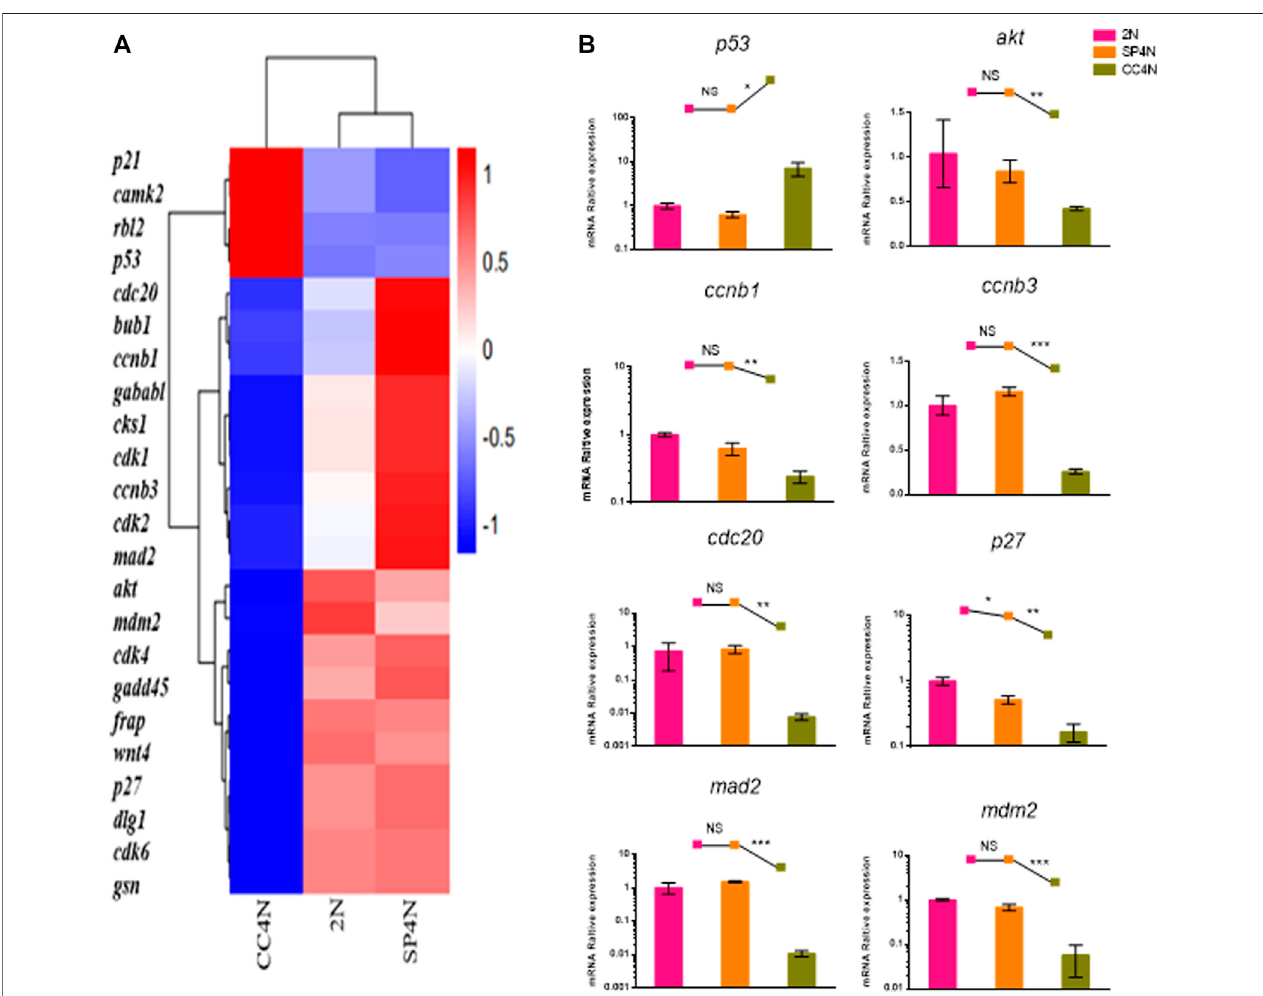
FIGURE 5 | Expression levels of cell cycle regulation genes detected by mRNA-seq and qRT-PCR in the SP600125 induced tetraploid cells (SP4N cells), in the tetraploidcellsfrom C.auratus × C.carpioL. (CC4Ncells)andinthediploid fi shcells(2Ncells). (A) Heatmapoftheexpressiondistributionofcellcycleregulationgenesas detected by mRNA-seq. (B) The expression levels of eight genes detected by qPCR. For each sample, experiments were repeated at least 3 times. “ NS ” stands for no signi fi cantdifference,* p ≤ 0.05,** p ≤ 0.01and*** p ≤ 0.001representthedifferentsigni fi cancelevelsoftheconducted t -test,respectively.Analysisofmitochondria- related energy metabolism